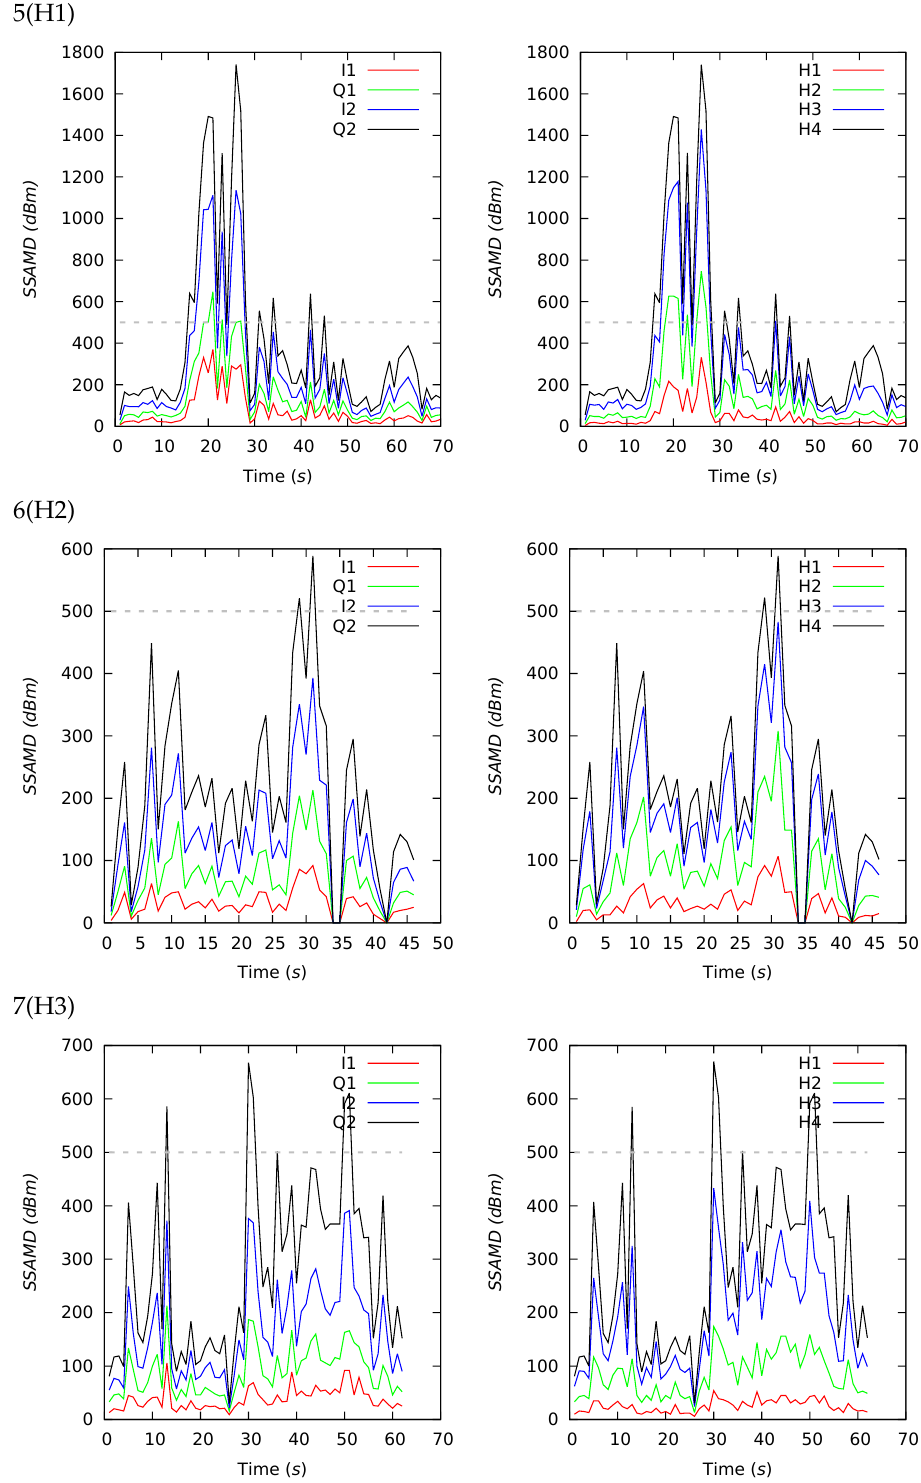
Figure A10. Experiment II, Sialis lutaria 5–7